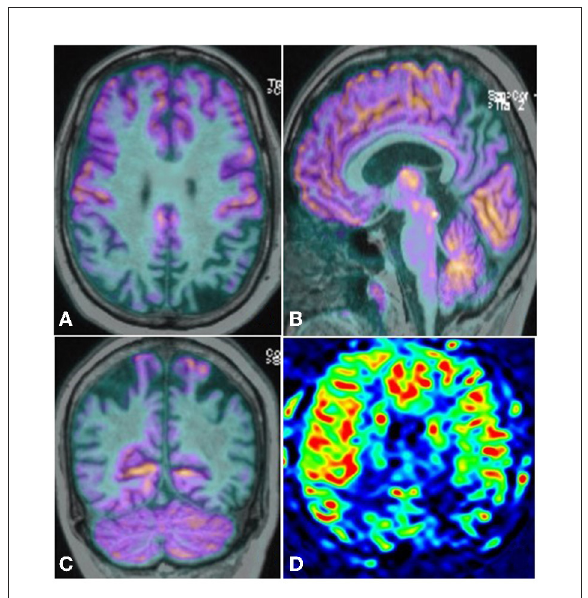
FIGURE3 FDG-PET Brain Axial (A) , Sagittal (B) , and Coronal (C) showing moderate to severe hypo metabolism predominantly involving the posterior parieto-occipital and temporal cortices with left predominance along with posterior cingulate gyrus. ASL image (D) showing reduced perfusion in bilateral parietal and parietotemporal with left affected more than right. Post cingulate gyrus hypoperfusion is also